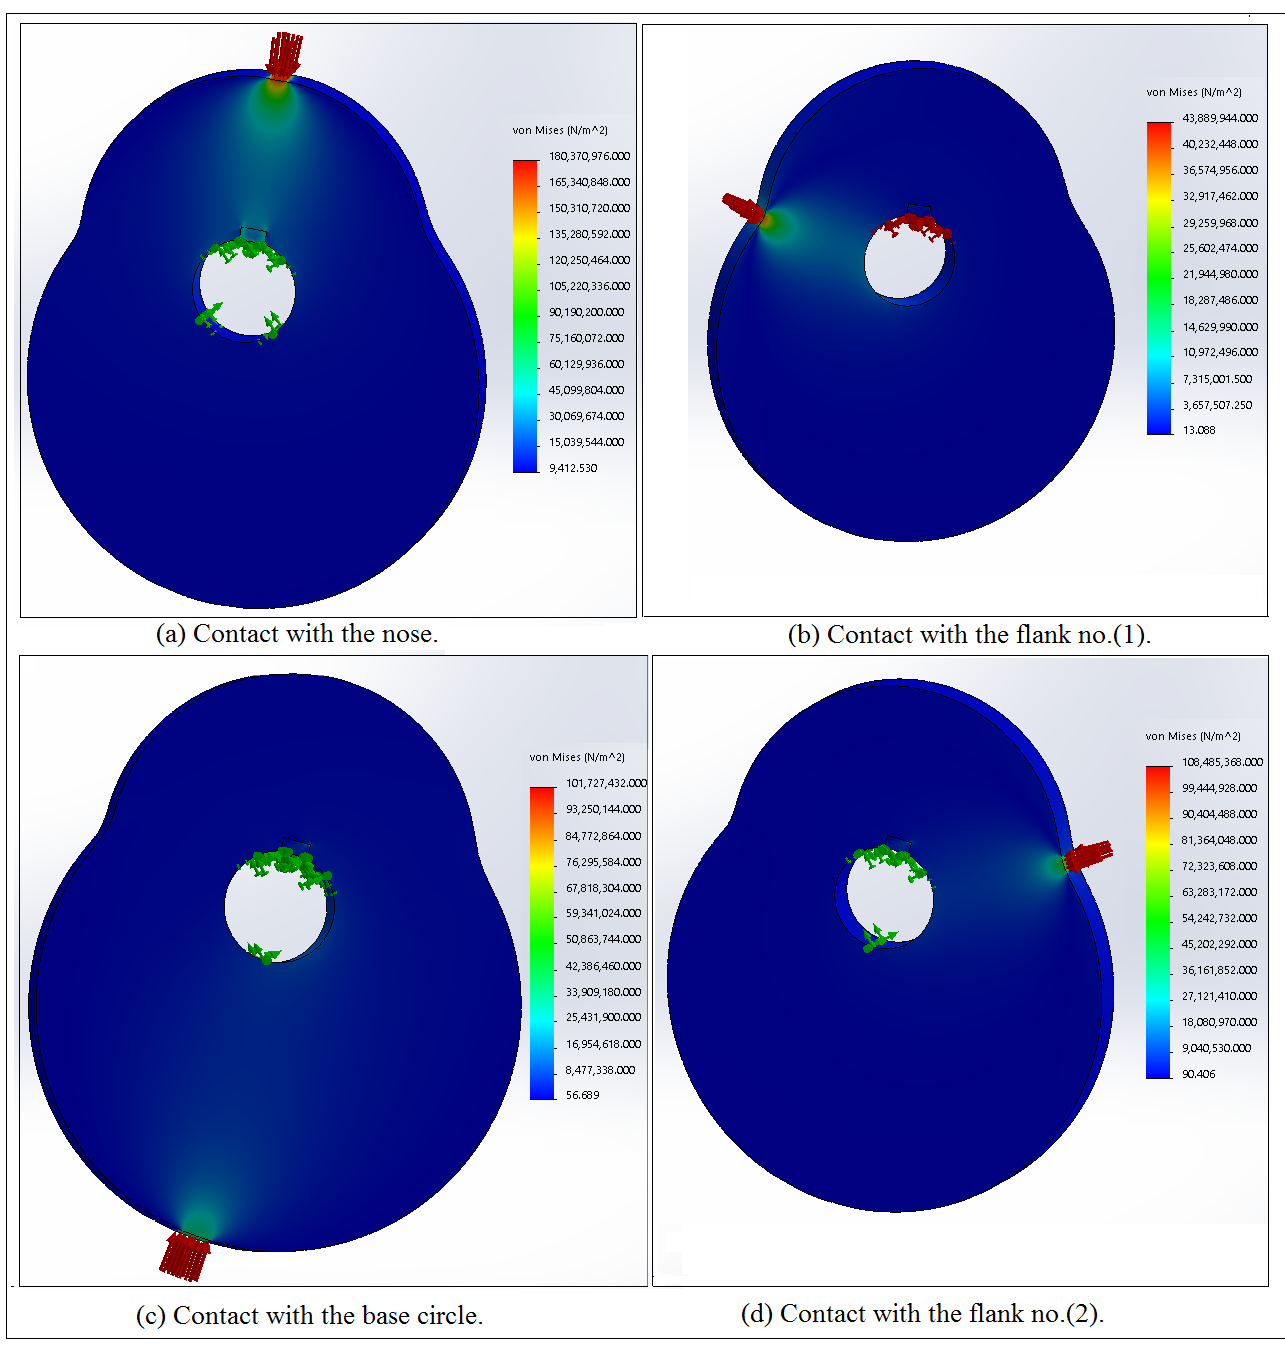
Figure 25. Von Mises stress mapping contour for profile no.(3) at different contact locations.